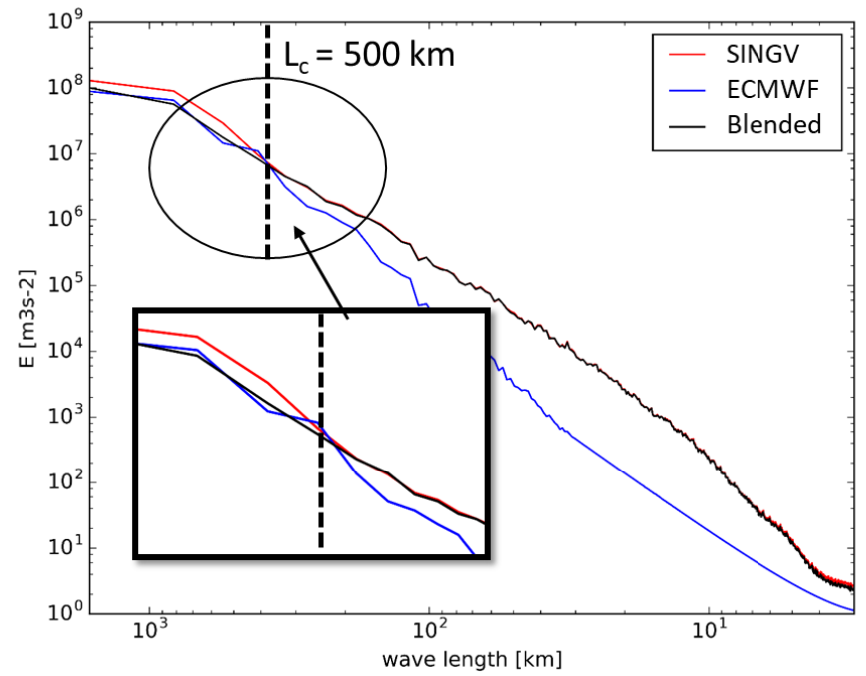
Figure 2. Comparing the horizontally averaged kinetic energy spectra at z = 5 km from unblended SINGV, ECMWF, and blended SINGV forecasts just after initialization to demonstrate the scale- selective nature of the used algorithm. Scales in wavelengths larger than Lc (=500 km) in unblended SINGV (in red) are replaced with that from the ECMWF forecast (in blue), resulting in the blended spectrum (in black).